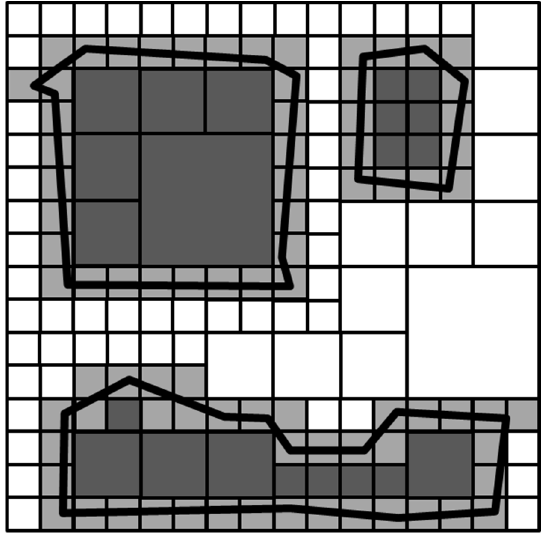
Figure 1. Examples of AHS model indices with the fourth level as the lowest quadtree level (interior: dark gray , boundary: light gray , and exterior: white ).